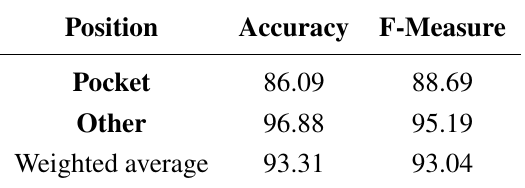
Table 12. Results of the 2-class pocket detection